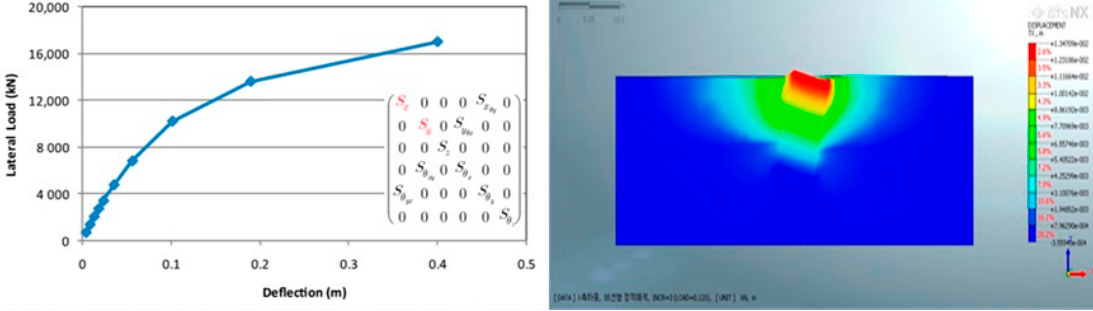
Figure 16. Evaluation of sti ff ness matrix of suction pile (example of F x - δ x , F y - δ y ).